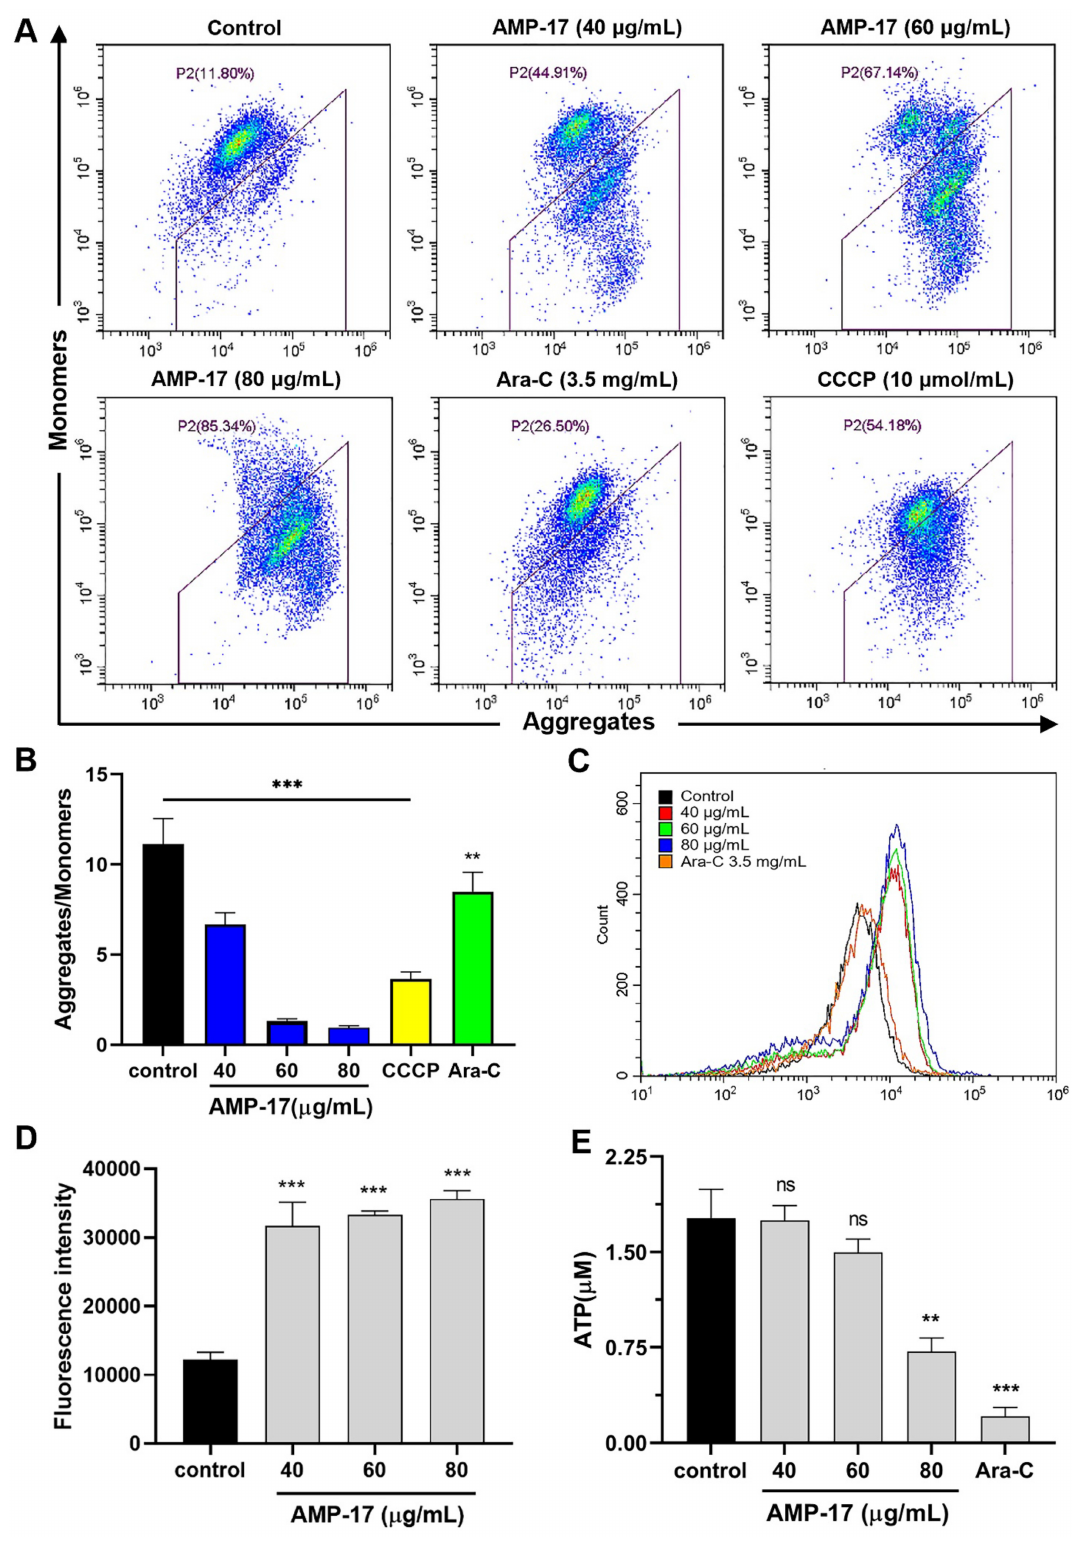
Figure 5. AMP-17-induced apoptosis may be achieved through ROS accumulation, calcium ion release and mitochondrial dysfunction. ( A ) Mitochondrial membrane potential (MMP) changes in K562 cells after 24 h of AMP-17 treatment were detected by using JC-1 staining. CCCP and Ara-C were used as positive control and drug control, respectively. ( B ) Statistical results of the ratio of aggregates to monomer fluorescence intensity of MMP (** p < 0.01, *** p < 0.001). The experiment was independently repeated three times. ( C ) Calcium ion levels in the intracellular of K562